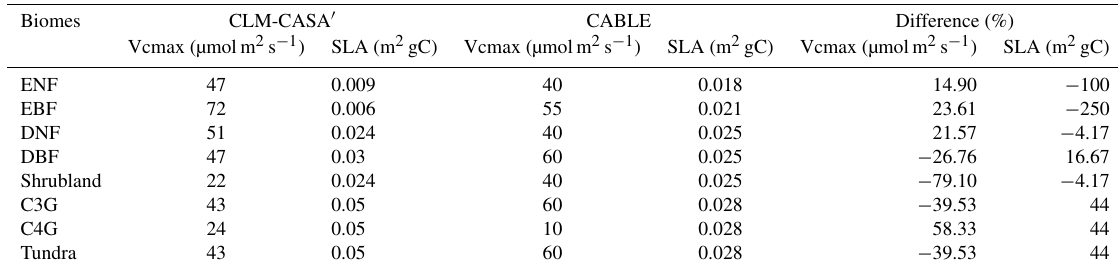
Table 1. Photosynthesis parameter values for different biomes in CLM-CASA (cid:48) and CABLE. Abbreviations of biomes are given in Fig. 1. The relative difference is calculated by CLM-CASA (cid:48) minus CABLE and then divided by CLM-CASA (cid:48) .